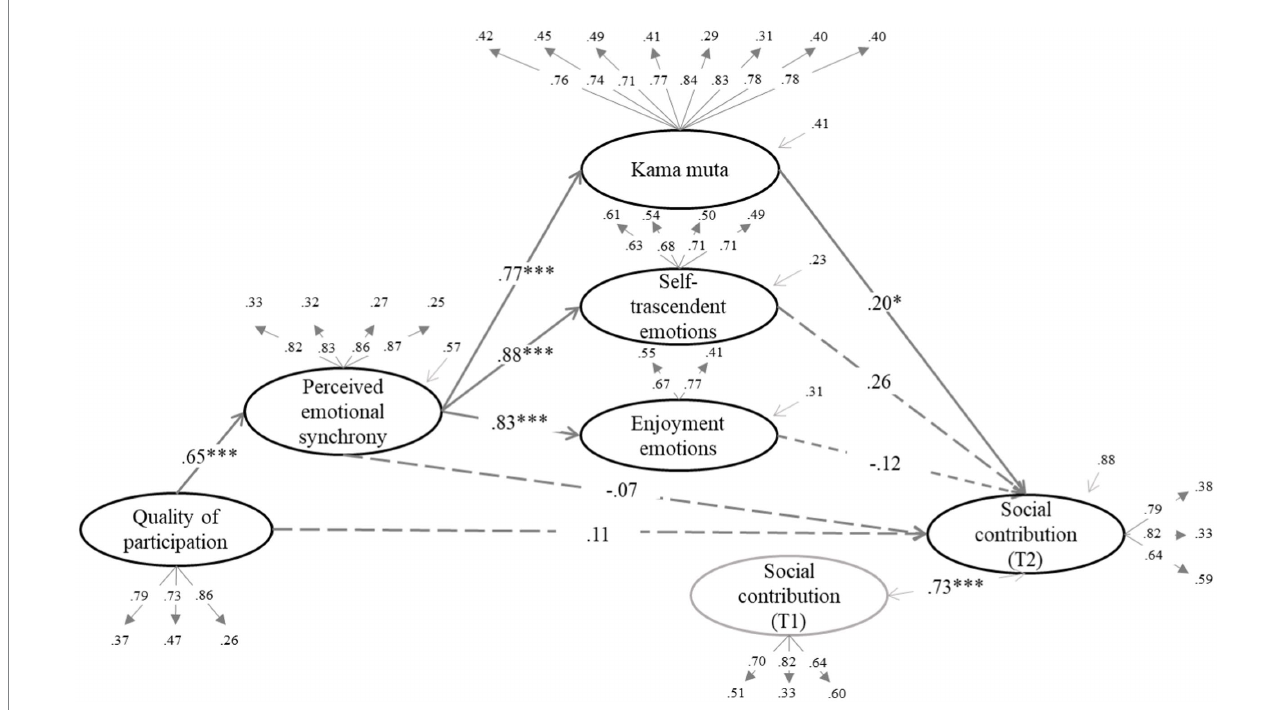
FIGURE 3 Perceived emotional synchrony and emotions as mediators of the effect of quality of participation on social contribution controlling for pre-participation scores. Model fit: χ 2 = (404, 313) = 881.122, p < 0.001, CFI = 0.912, TLI = 0.901, RMSEA = 0.067. SRMR =